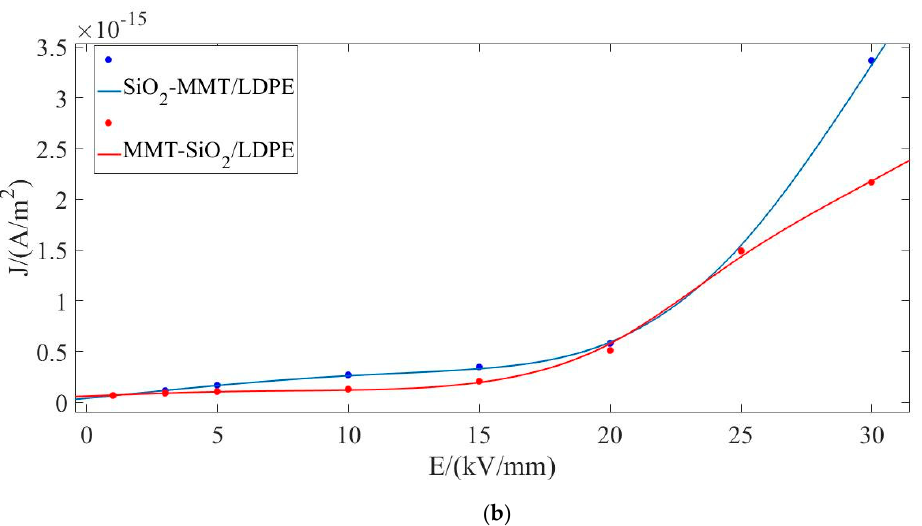
Figure 6. Curve-fitting figure of conductance current of each composite material changing with field intensity. ( a ) The fitting figure for LDPE, MMT / LDPE, and SiO 2 / LDPE; ( b ) The fitting figure for SiO 2 -MMT / LDPE and MMT-SiO 2 / LDPE.